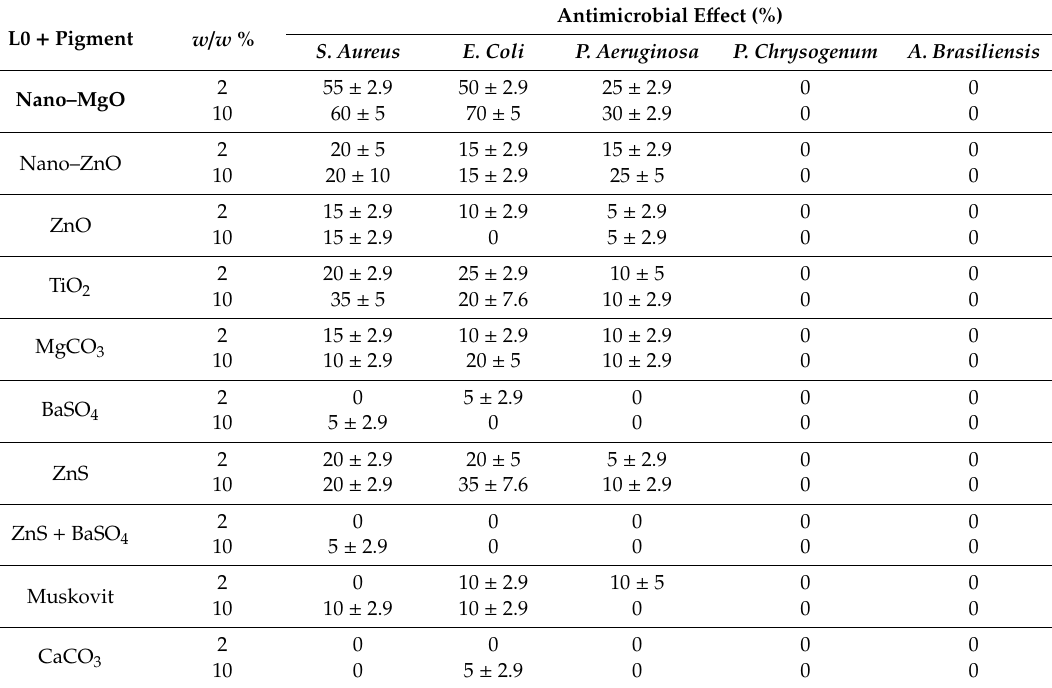
Table 10. Antimicrobial e ff ect of L0 coating